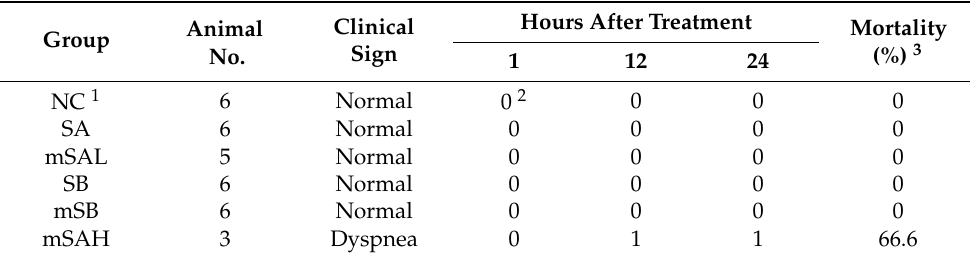
Figure 2. Gross lesion of lungs of rats after intratracheal instillation with unmodified and modified nano-silica in the acute pulmonary toxicity on Day 1. Gross lesions of lungs in negative control group ( A ), SA group ( B ), mSAH group ( C ), mSAL group ( D ), SB group ( E ), and mSB group ( F ) were found in rats at Day 1. Arrow. Table 9. Clinical signs and time course of death of rats after intratracheal instillation with unmodified and modified nano-silica on Day 1.